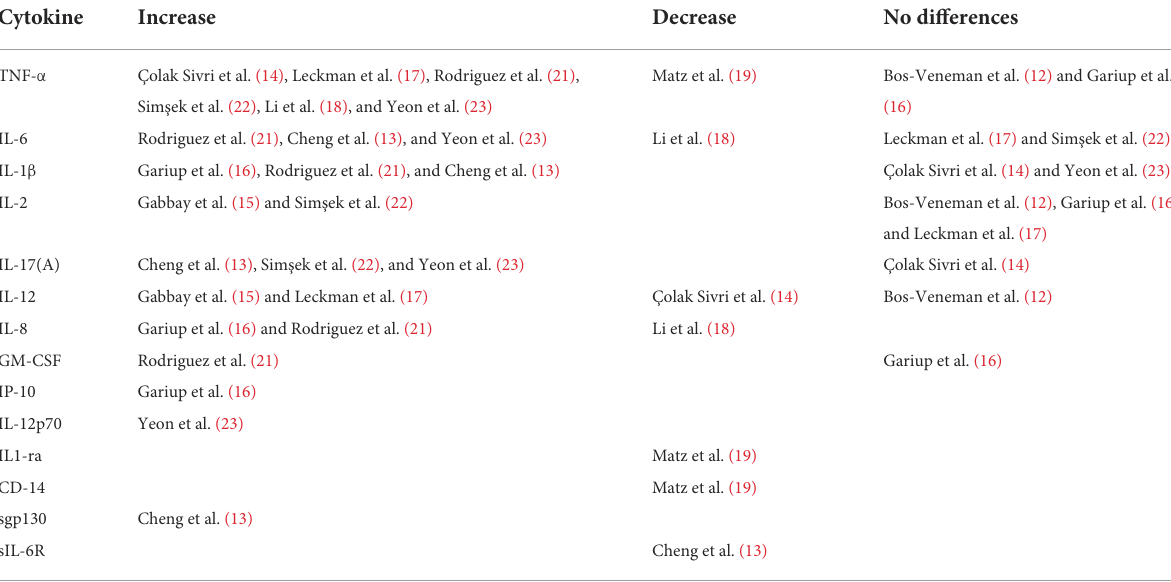
TABLE 2 Overview of cytokine changes in studies in pediatric patients with tics and/or obsessive-compulsive symptoms compared to healthy controls. Cytokine Increase Decrease No